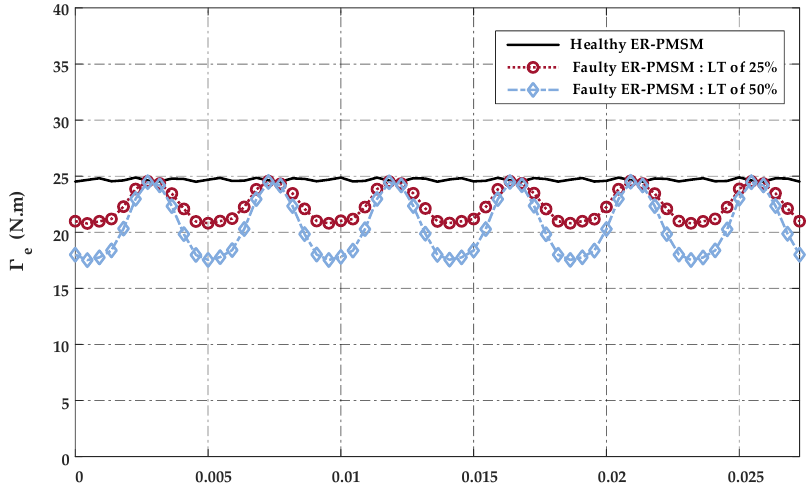
Figure 13. Electromagnetic torque comparison.